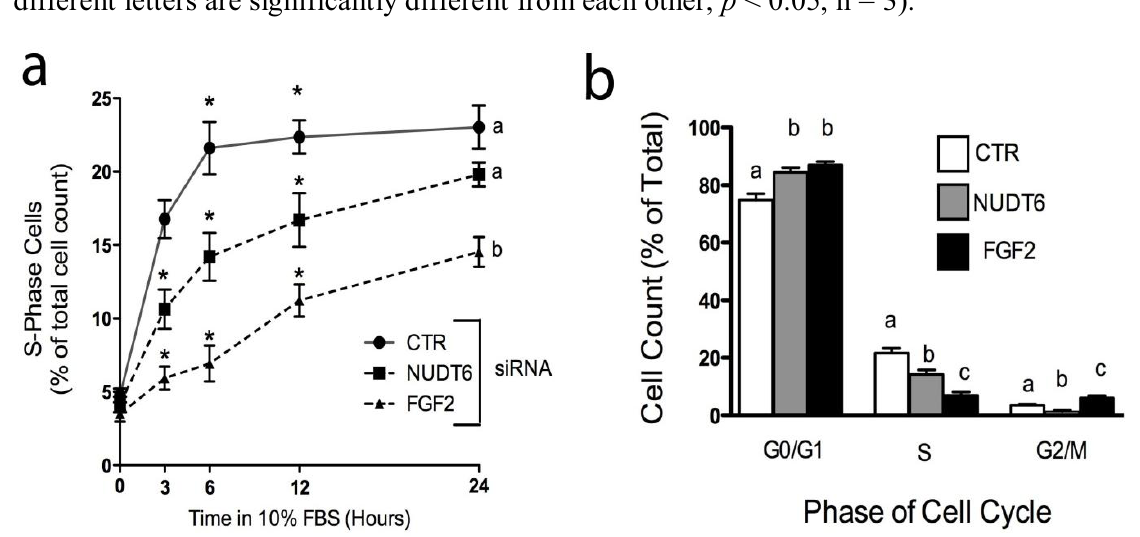
Figure 7. Effect of FGF2 and NUDT6 knockdown on S-phase entry and cell cycle progression. ( a ) The percentage of cells in S-phase at the indicated times following return to 10% FBS. *, p < 0.05 vs . other treatments at each time point. Groups with different letters are significantly different from each other, p < 0.05, n = 3; ( b ) Cell cycle distribution determined 6 hours after serum readdition. For each phase, all groups with different letters are significantly different from each other, p < 0.05, n =